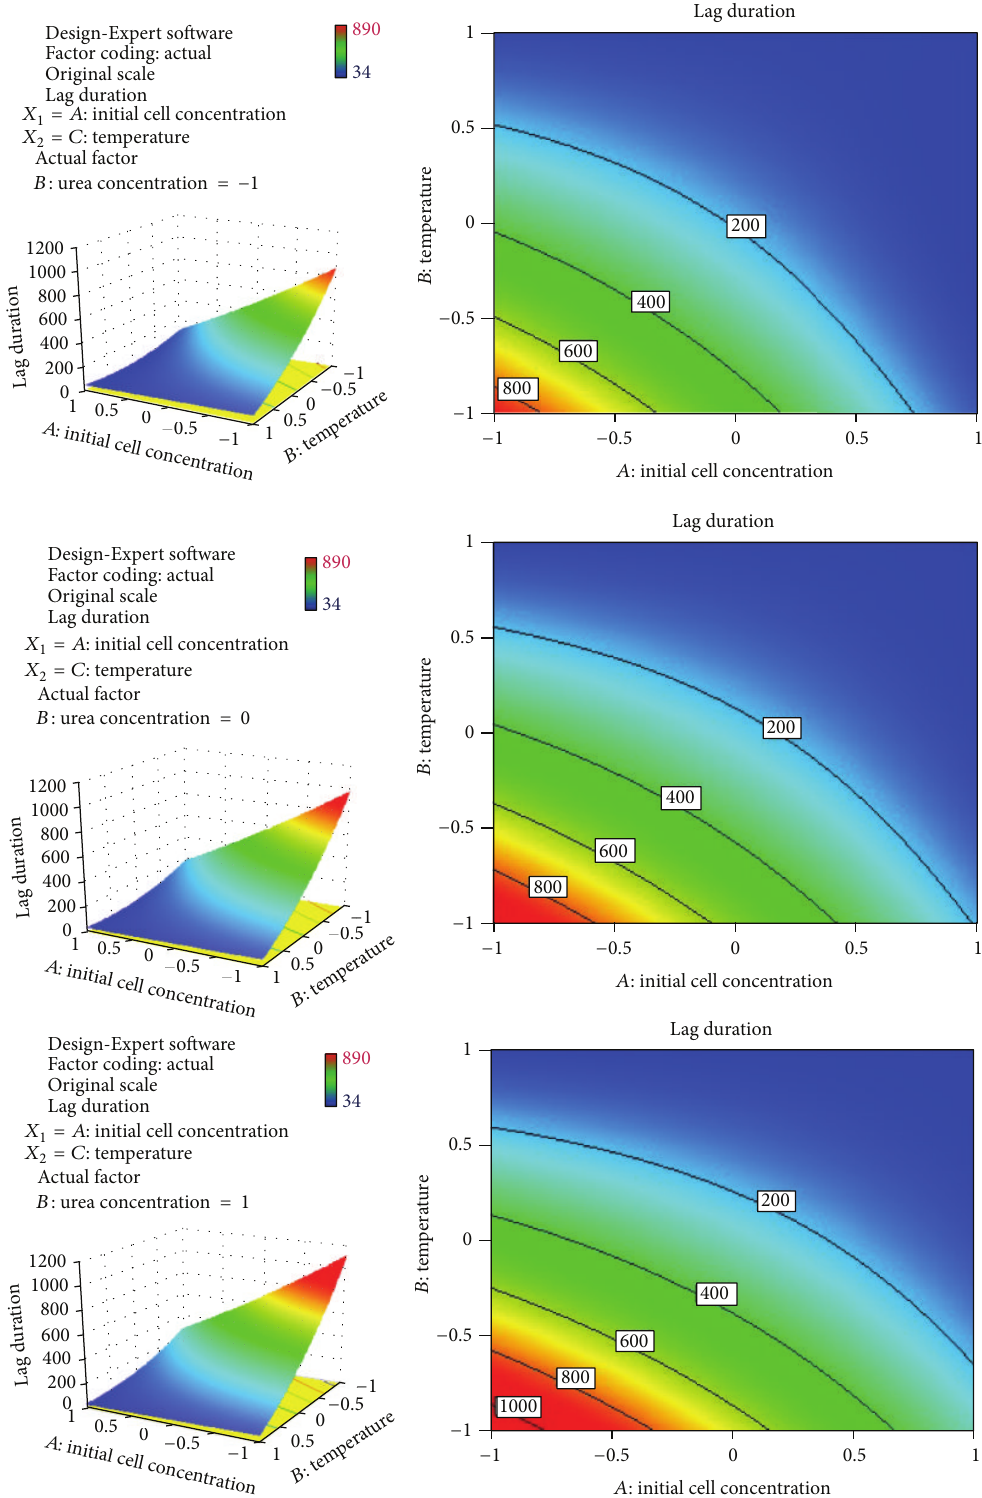
Figure 7: Response surface plots of the mutual effect of the factors on the lag